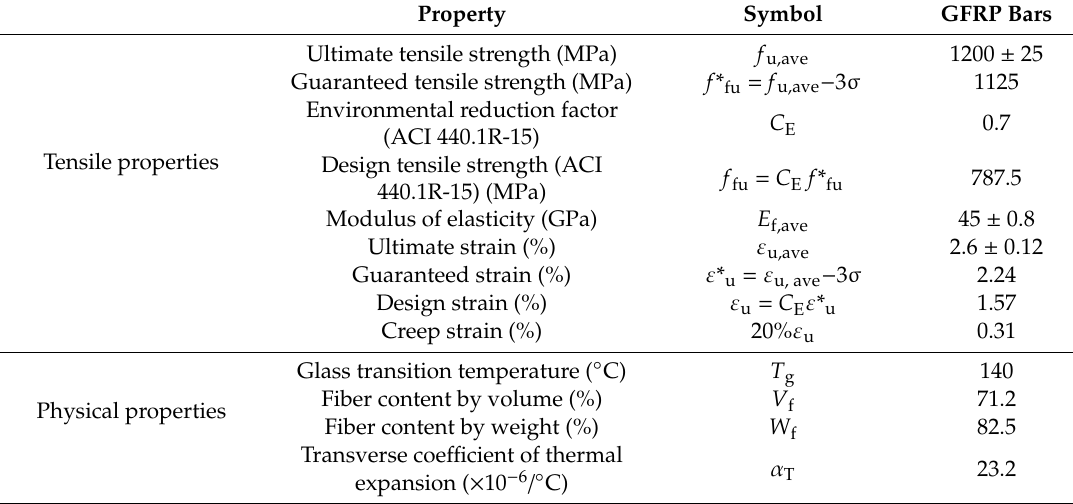
Table 3. Compositions of simulated seawater and concrete pore solutions.